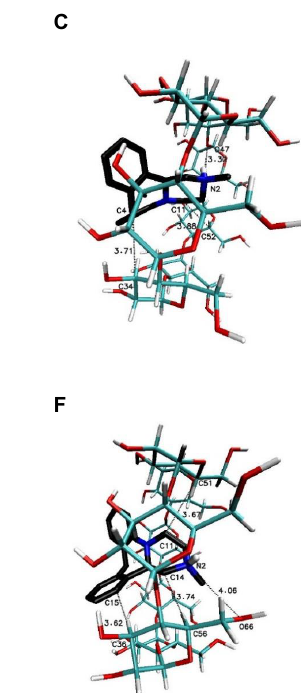
FIGURE 6 The chosen geometries of the MIA-βCD complex with stoichiometry 1:2 (I-II or "head to head" orientation of βCDs for B1 , B2 and II-III or Figure 6. The chosen geometries of the MIA– β -CD complex with stoichiometry 1:2 (I-II or “head-to-head” orientation of "head to tail" orientation of βCDs molecules to each other [36,37]for C1 , C2 ) obtained by MD simulations with the use of βCD crystal structure with β -CDs for ( A , C ), and II-III, or “head-to-tail” orientation of β -CDs molecules to each other [36,37] for ( B , D ) obtained by MD refcode 648855 from the CSD data base [38]; B1 and C1 for S-(+)-MIA·HCl, B2 and C2 for R-(-)-MIA·HCl. simulations with the use of β -CD crystal structure with refcode 648855 from the CSD data base [38]; ( A , B ) for S-(+)-MIA · HCl and ( C , D ) for R-( − )-MIA · HCl.